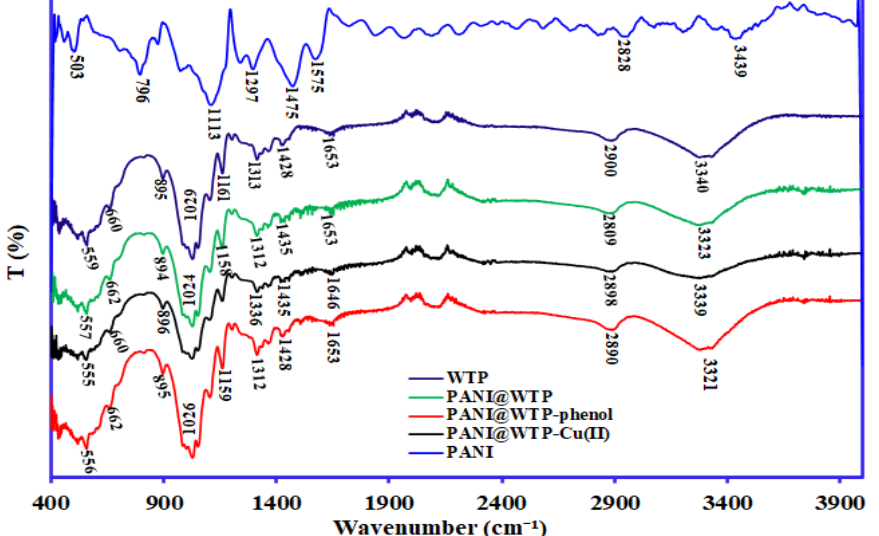
Figure 3. TEM images of ( a , b ) WTP and ( c ) PANI@WTP nanocomposite.